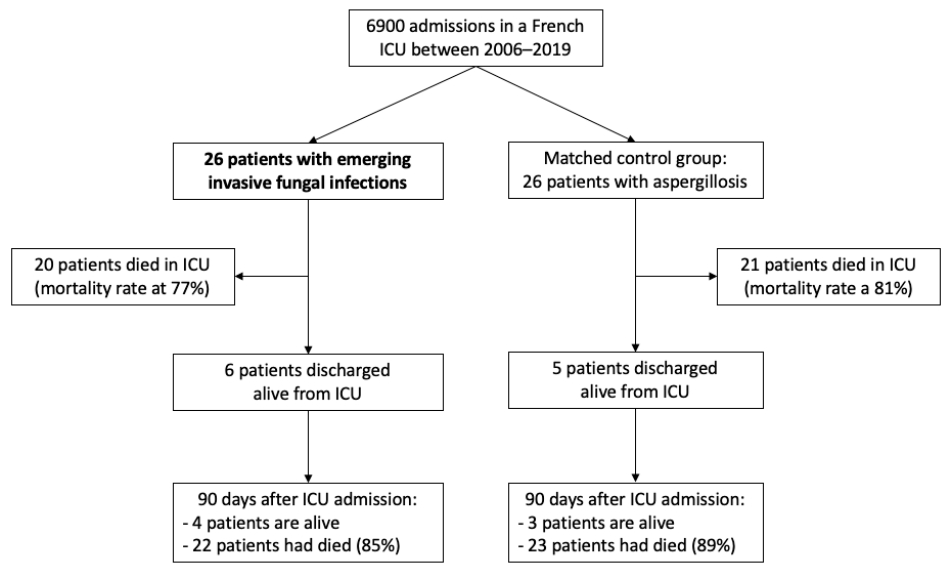
Figure 1. Flow chart of the study population.